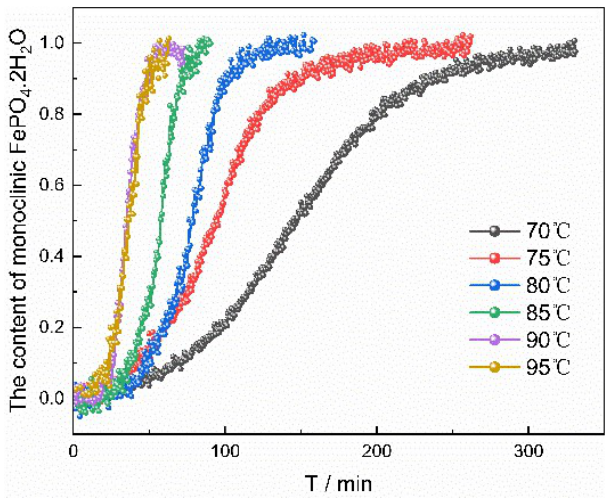
Figure 14. The percentage content of monoclinic FePO 4 · 2H 2 O vs. time at different temperatures. Table 6. Fitting parameters of JMA model at 90 °C.